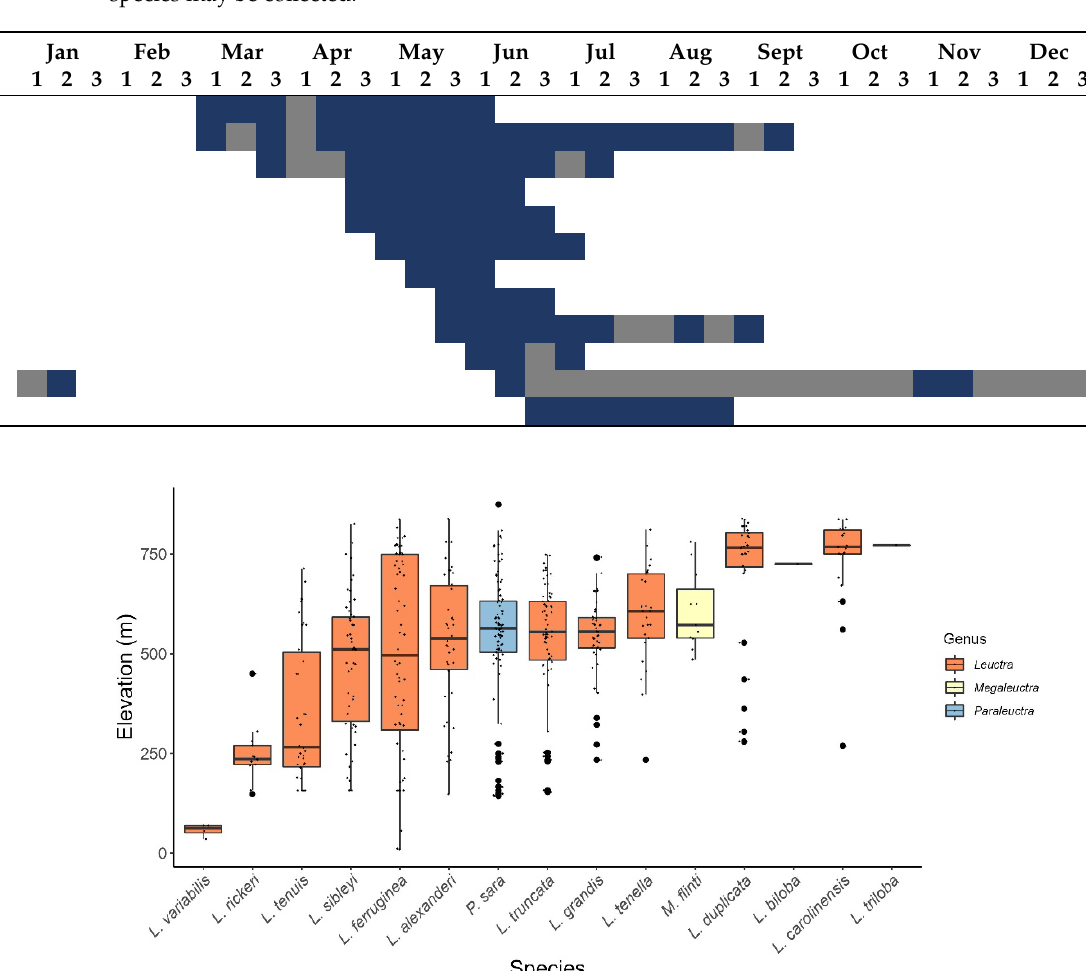
Table 6. Recorded adult Leuctridae presence in Maryland. Months are broken into three 10-day periods. Dark blue squares represent periods with collections. Gray squares represent periods when species may be collected.